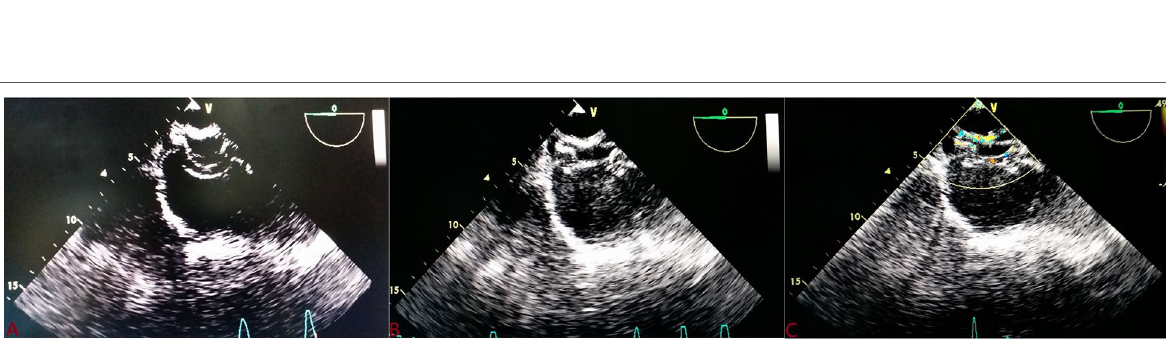
Fig. 9 TEE showing proper placement of device with disks catching the rim properly ( A ; B ) and post-deployment residual shunts ( B